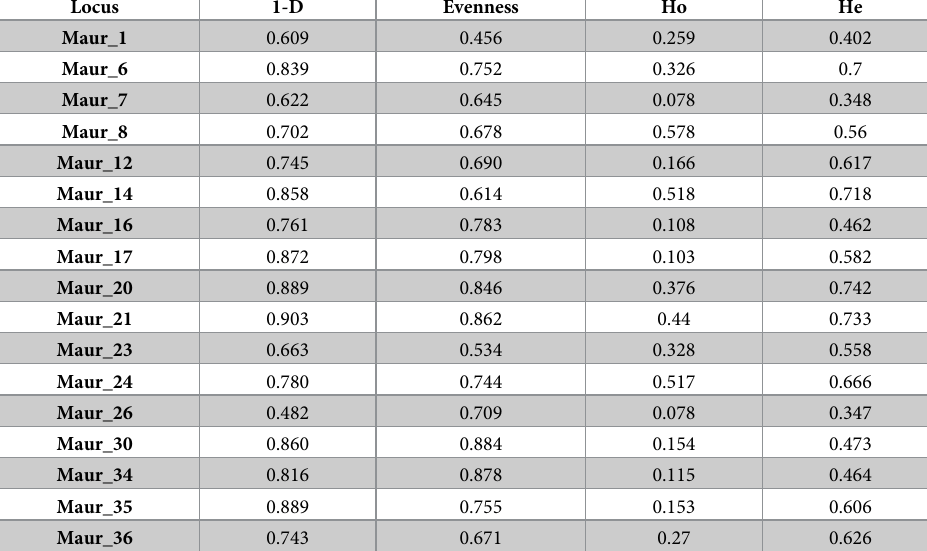
Table 1. Allelic diversity of M . auretenra microsatellite loci. Gene diversity measure (1-D), Evenness, observed (Ho) and expected (He) heterozygosity. Locus